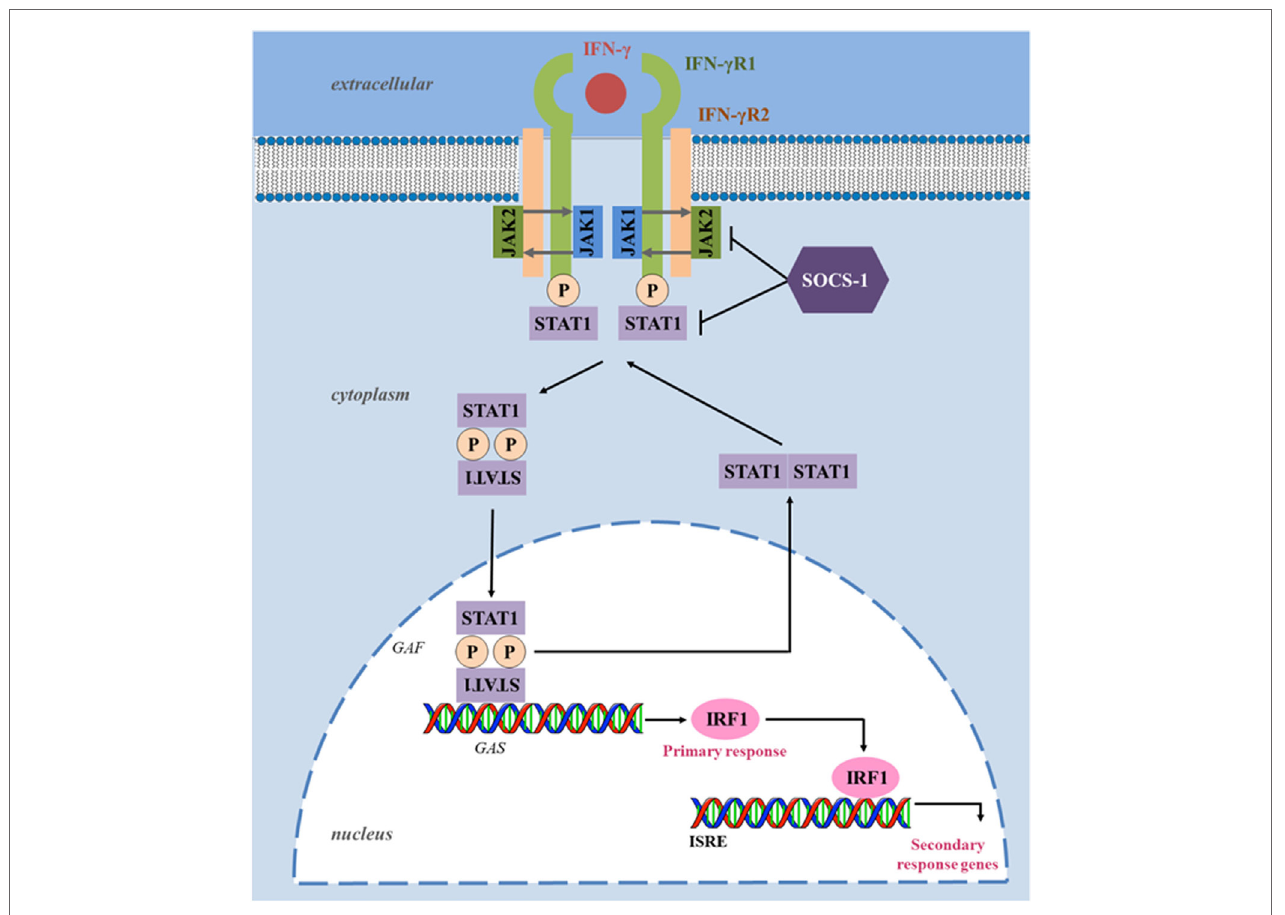
FiGURe 1 | Interferon-gamma (IFN- γ ) canonical signaling pathway. Upon ligand binding, IFN γ R1 and IFN γ R2 oligomerize and transphosphorylate, activating Janus activated kinase (JAK) 1 and JAK2. These, in turn, phosphorylate IFN γ R1, creating a docking site for the signal transducer and activator of transcription (STAT) 1. Phosphorylated STAT1 homodimerizes in an antiparallel configuration, forming a complex gamma-activated factor (GAF), which translocates to the nucleus and binds to gamma-activated site (GAS), located at the promoters of primary response genes, increasing their transcription. Upon induction, transcription factor interferon- regulatory factor 1 (IRF1) binds to interferon-stimulated response element (ISRE) and enhances the transcription of several secondary response genes responsible for several immunomodulatory functions. Suppressor of cytokine signaling (SOCS) proteins negatively regulate the IFN- γ pathway by inhibiting JAKs and STAT1 phosphorylation. Through dephosphorylation and deacetylation, the configuration of STAT1 homodimers reverts to parallel, triggering their exit from the nucleus .